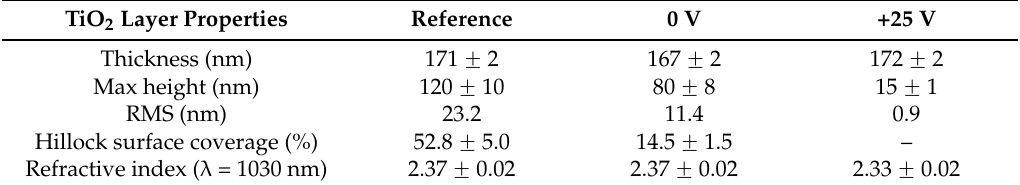
Figure 4 . AFM measurement of the surface of TiO 2 layers deposited on Si substrate under the following process conditions: 300 W plasma power; 100 °C substrate temperature; 10 sccm oxygen gas flow corresponding to 5.7 Pa chamber pressure at DC BIAS ( a ) 0 V; and ( b ) +25 V. Table 1. Film properties of the reference sample, and the layers deposited at DC BIAS 0 V and +25 V. TiO 2 Layer